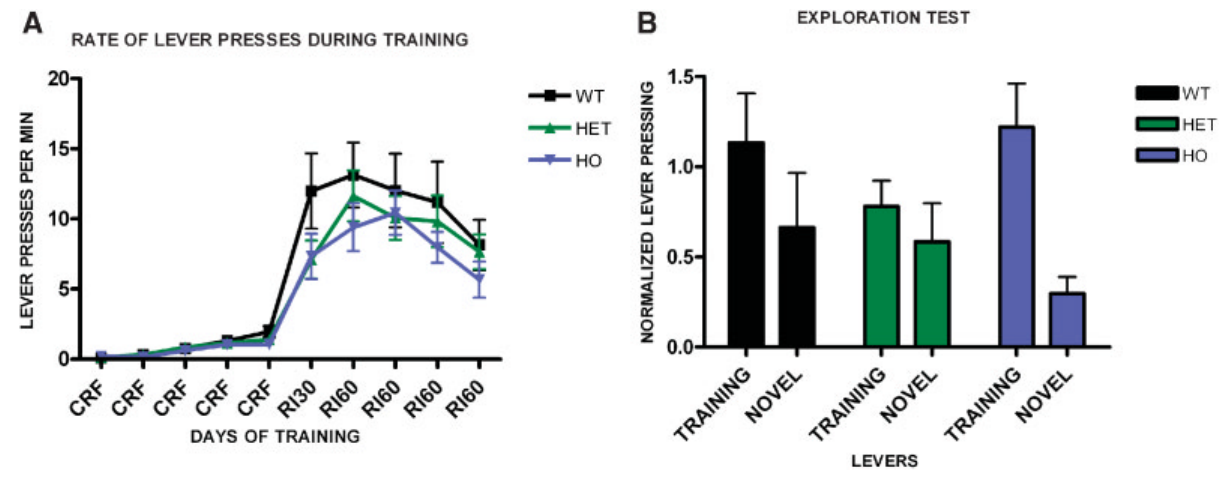
Figure 6. Exploration versus exploitation in WT, CB1 +/ − , and CB1 − / − mice . ( A ) Acquisition of the lever pressing task in WT, CB1 +/ − , and CB1 − / − mice animals trained on a random interval schedule. The rate of lever pressing per minute for each daily session is depicted. ( B ) Lever pressing (normalized) on the training lever versus a novel lever in WT, CB1 +/ − , and CB1 − / − mice.